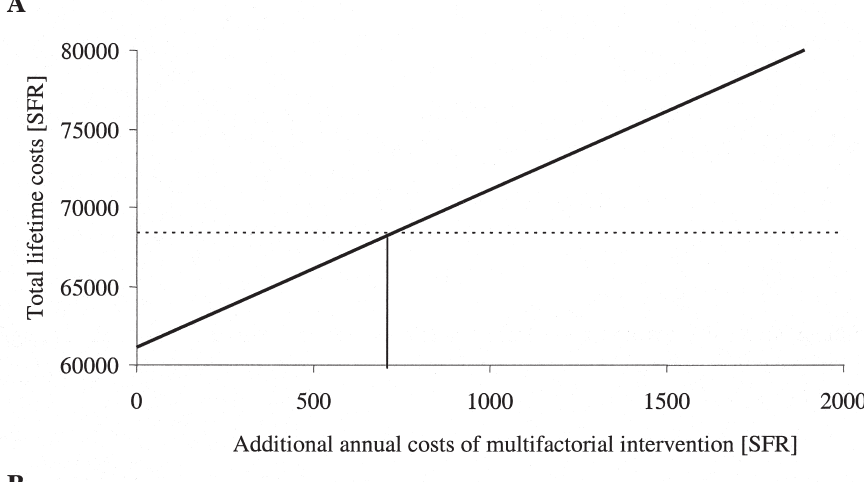
Break-even analysis of additional annual costs and compliance of multifactorial